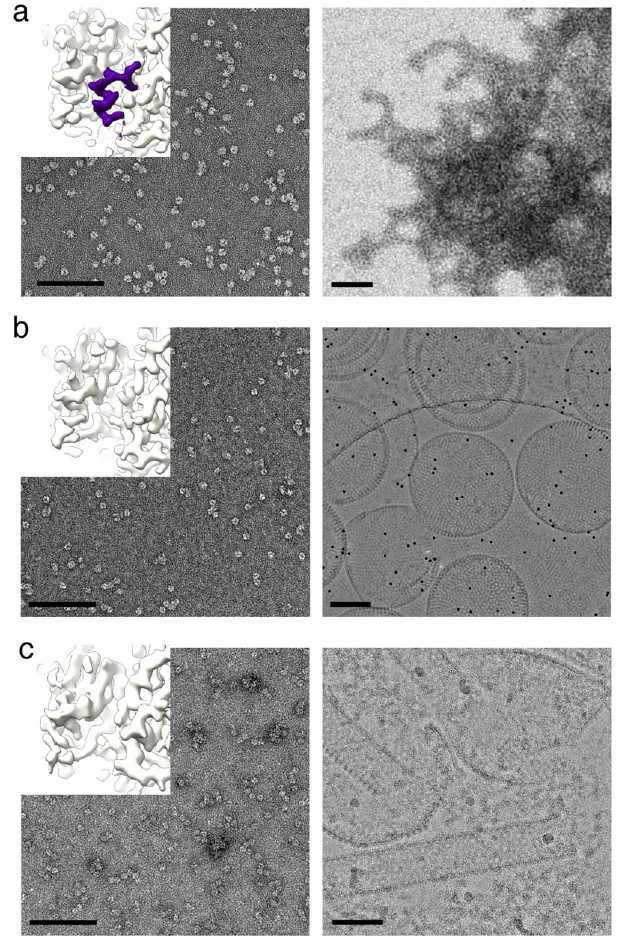
Fig. 3 Assembly of D13 requires displacement of the N-terminal tail α -helix. Transmission electron micrographs of a wtD13, b His 6 -tagged D13 and ( c ) D13 18-548 , before (left column) and after (right column) low-salt buffer-mediated assembly. Images are of negatively stained samples, except in the right column of b and c where images of vitri fi ed samples captured by cryo-EM are shown for clear morphological observation. Insets show details of the respective contoured cryo-EM